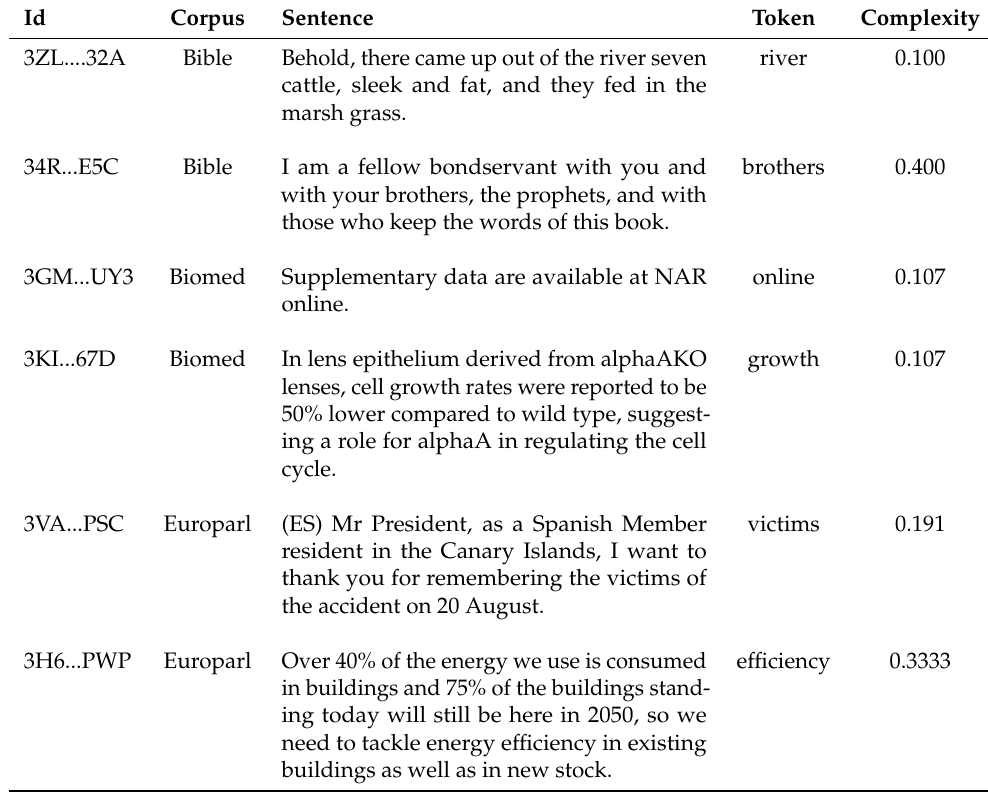
Table 1. Sample entries from